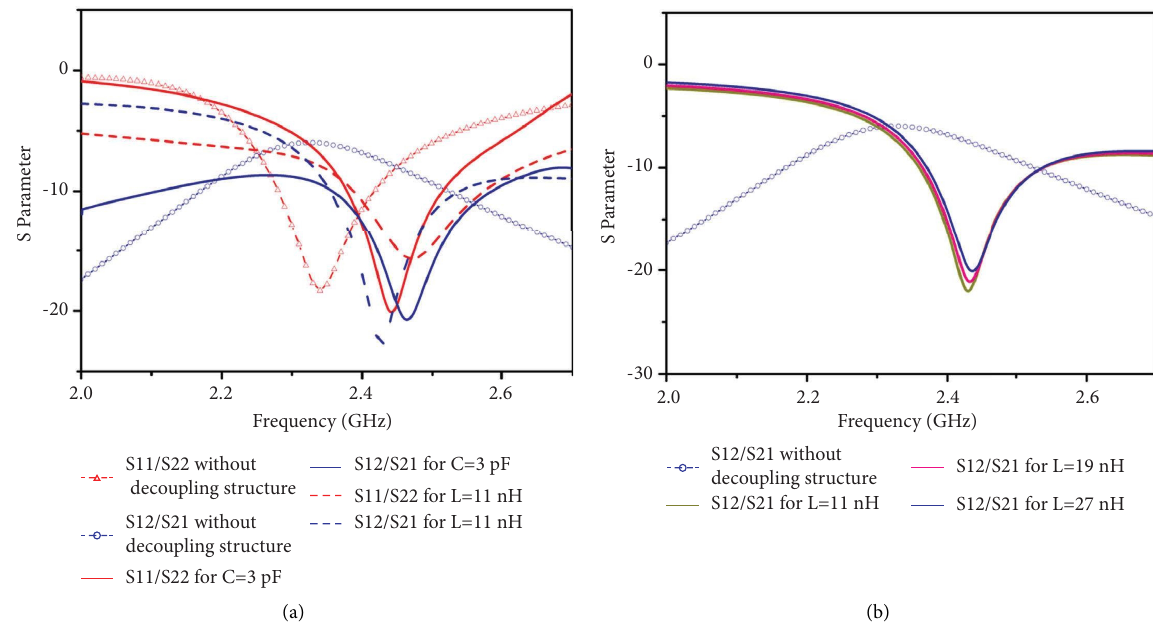
Figure 4: (a) Simulated S -parameters of the conventional antenna model without the decoupling elements (dot lines with a circle) and the proposed isolation improvement system with the decoupling structure and C � 3 pF (full line) or L � 11nH (dot line). (b) Isolation ( S 12/ S 21) at diferent L from 11nH to 27nH.